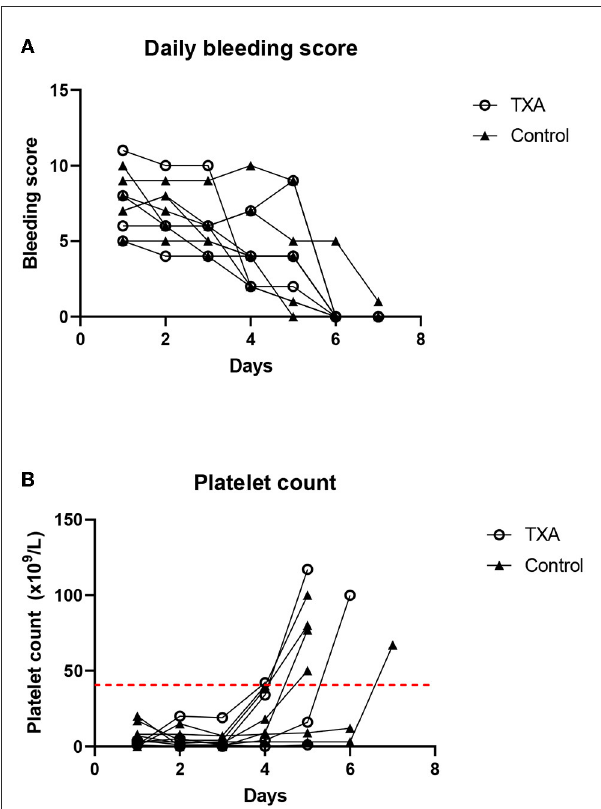
FIGURE1 (A) The daily bleeding score for individual dogs in the tranexamic acid (TXA) and the control group. (B) Daily platelet count for individual dogs in the TXA and the control groups. The dashed red line indicates the cutoff for remission ( > 40 × 10 9 /L).